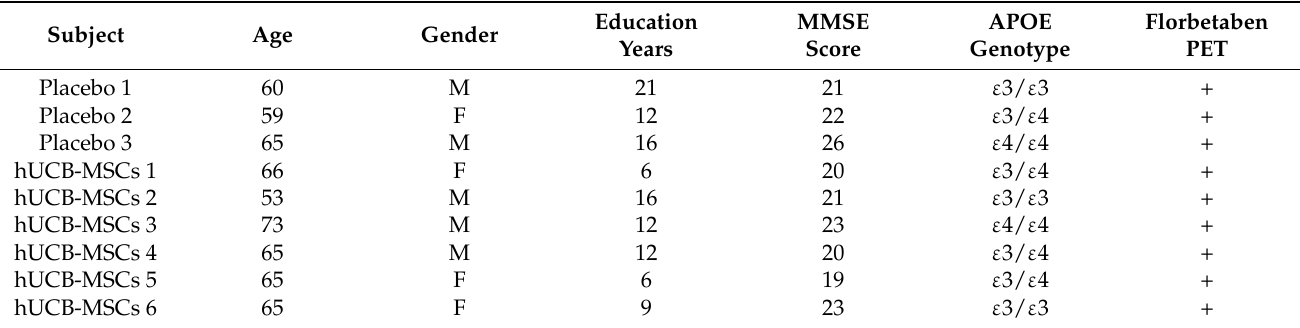
Table 1. Baseline characteristics of AD